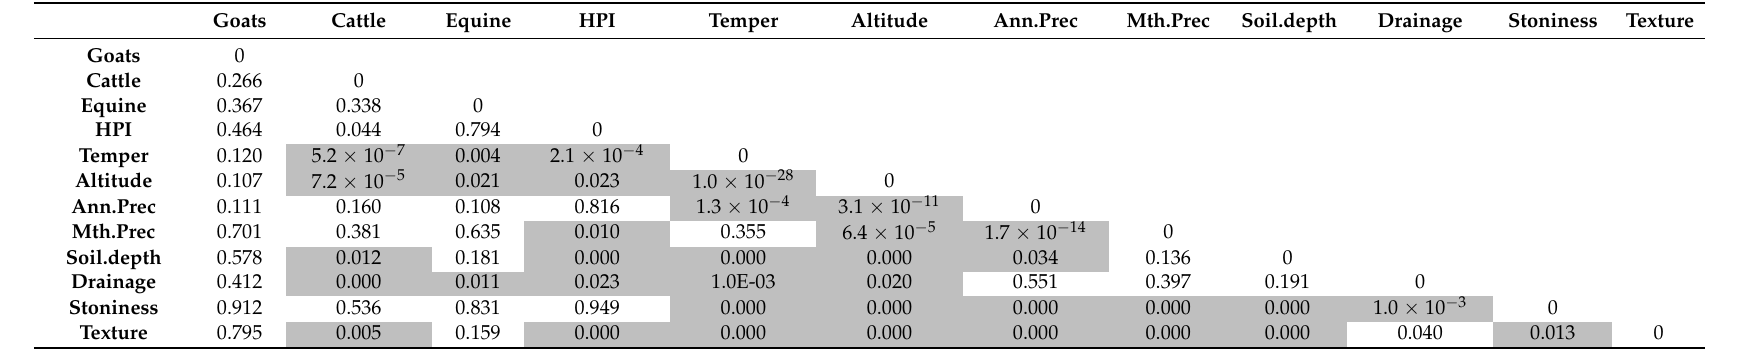
Table 1. p -Values obtained in the Pearson’s correlation test of predictor variables. Correlated variables are shaded. Goats Cattle Equine HPI Temper Altitude Ann.Prec Mth.Prec Soil.depth Drainage Stoniness